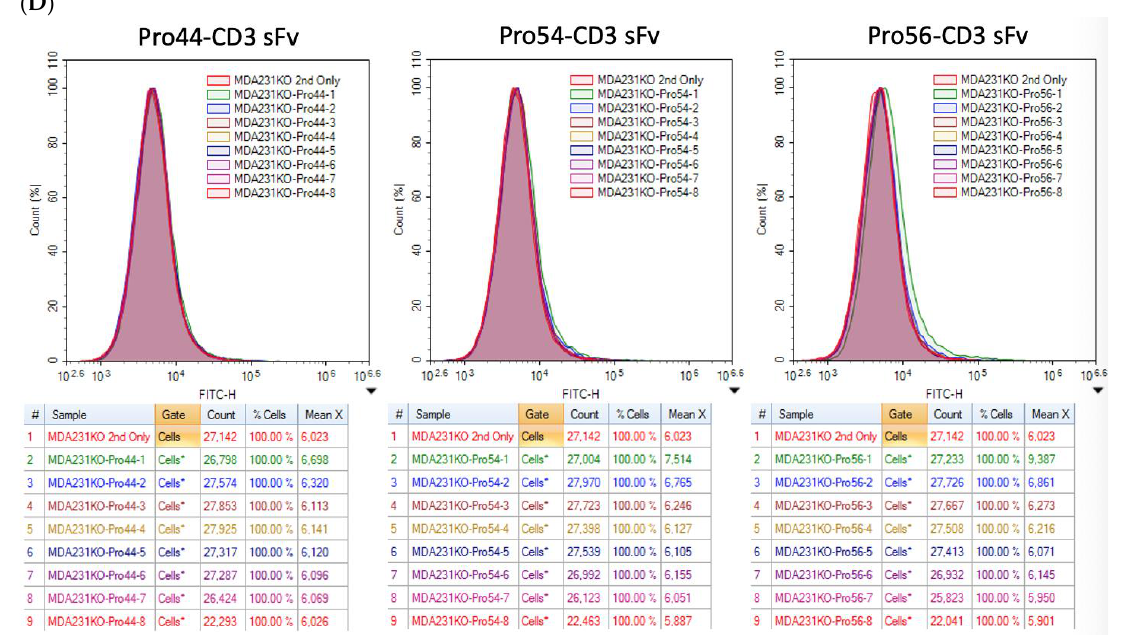
Figure 7. ( A ) Shows specific binding of anti-AXL-APC conjugated antibody to MDA-MB-231 cells and no binding to the AXL Knockout cells. ( B ) Distinguishing specific binders from non-specific binders by FACS. ( C ) Axl Pronectins (44, 54, and 56 starting at 500 nM, 1:4 dilution for 8 points) showing AXL binding titration on MDA-MB-231 cells. ( D ) The three AXL Pronectins show no to little binding on the AXL Knockout cells.